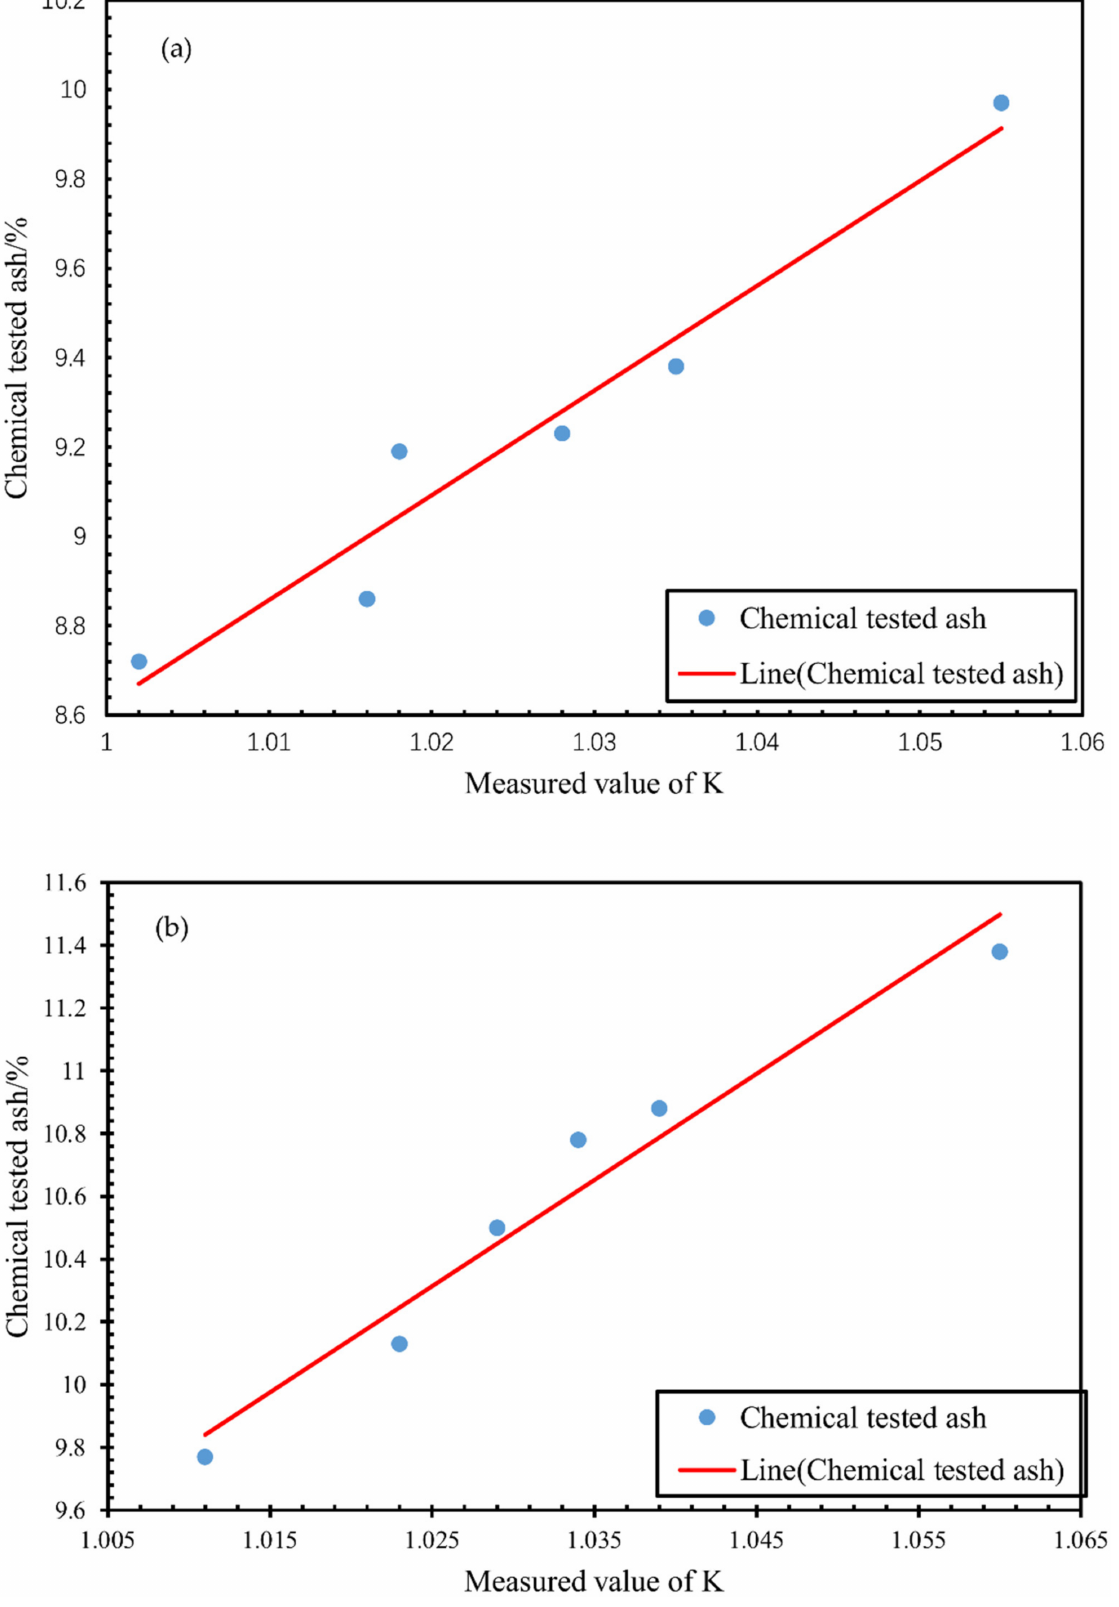
Figure 3. Relationship between A d and measured K for coal samples from the Suntuan Mine ( a ) and Xutuan Mine ( b